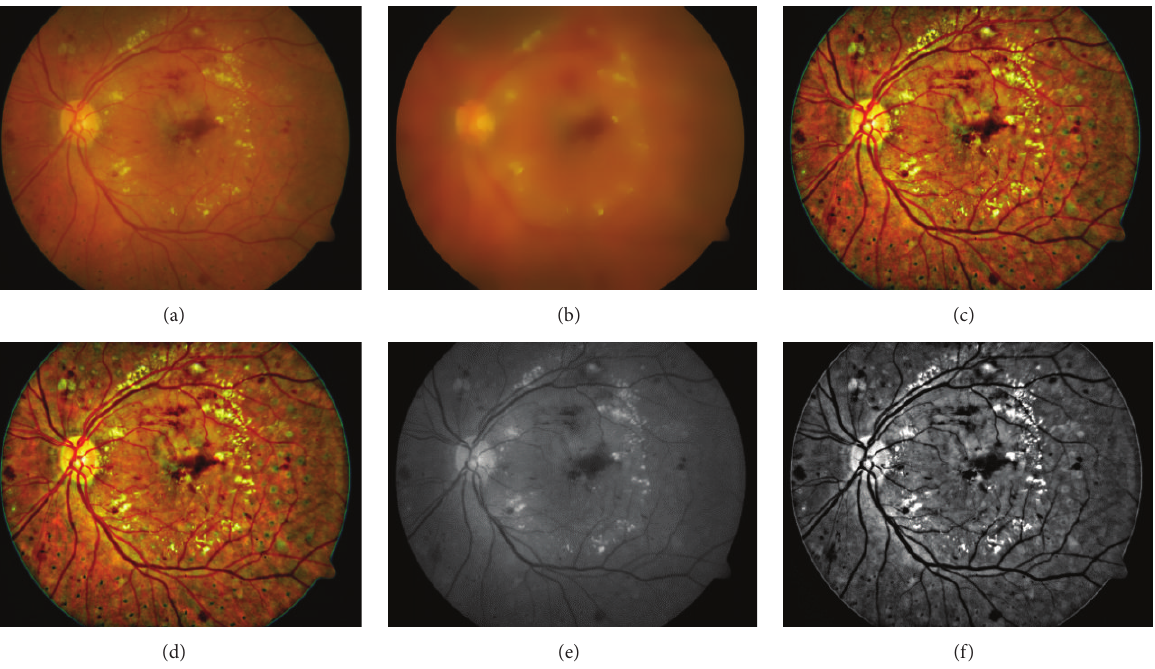
Figure 6: The image enhancement results of an image selected from the DIARETDB1 database. (a) Original image; (b) normalized convolution result; (c) fusion result; (d) denoising result; (e) green channel of original image; (f) green channel of denoising